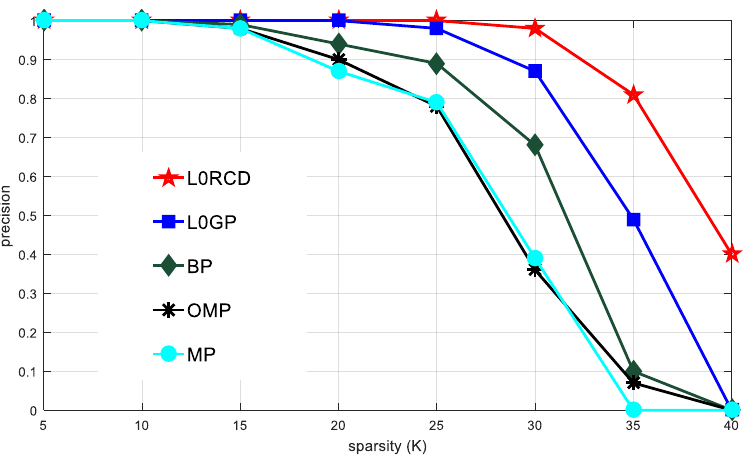
Figure 10. Precision comparison of the five algorithms (changed K ).